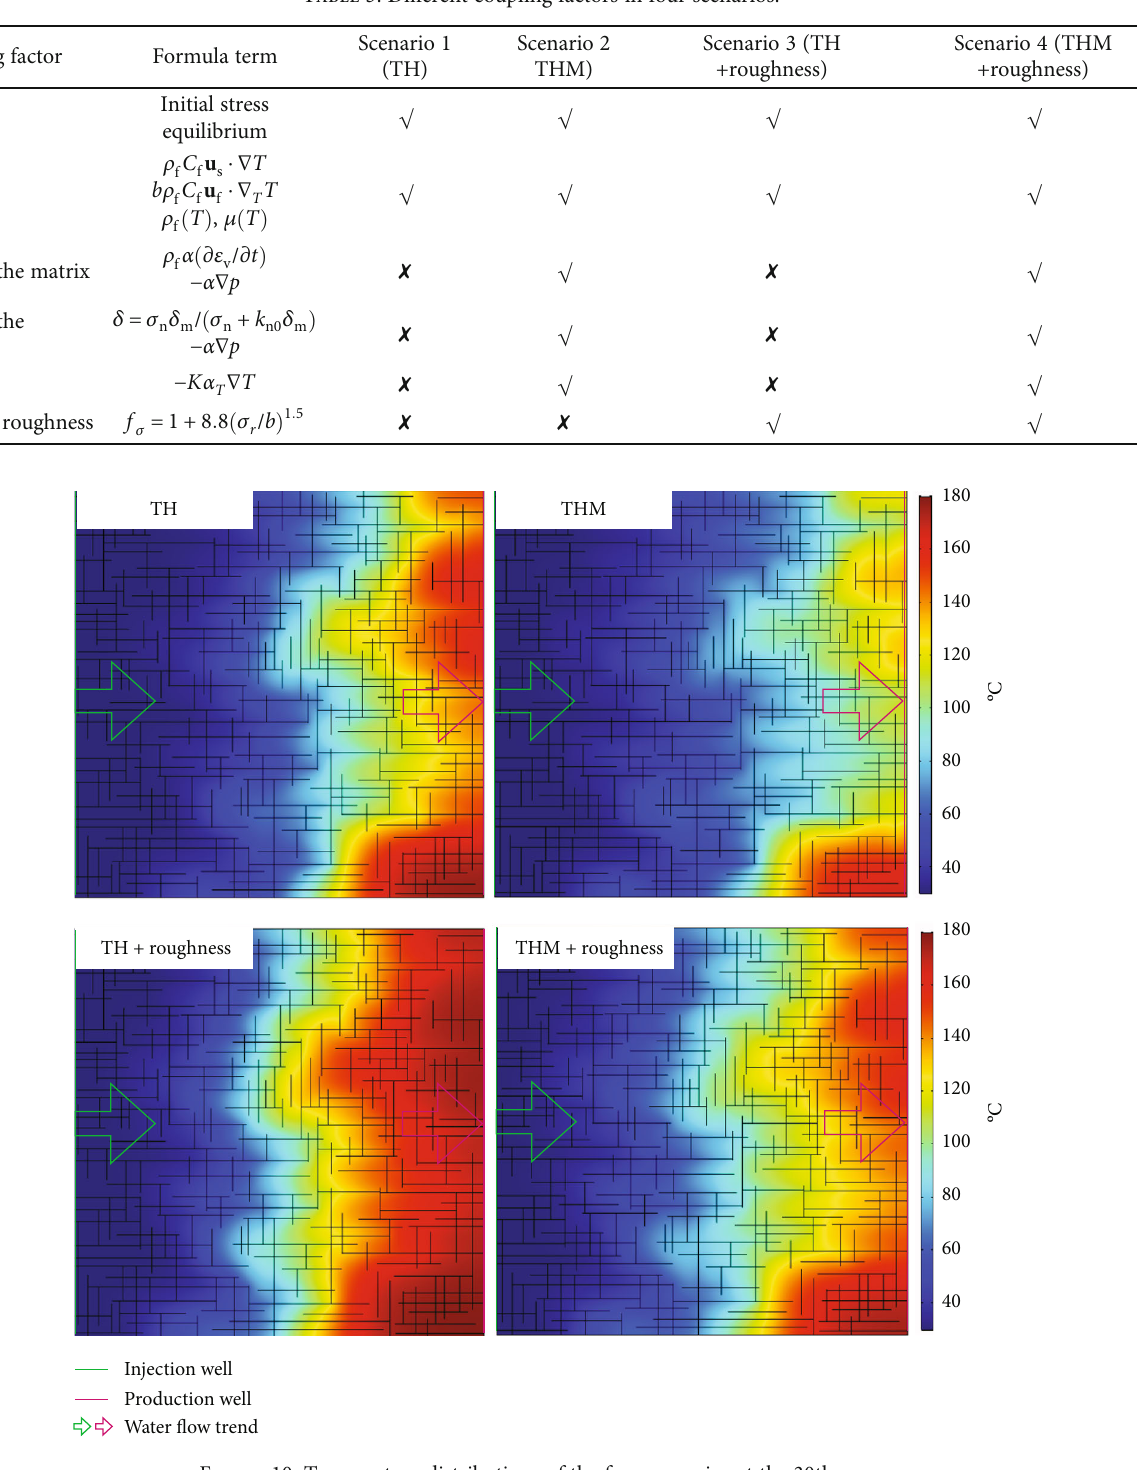
Figure 10: Temperature distributions of the four scenarios at the 30th